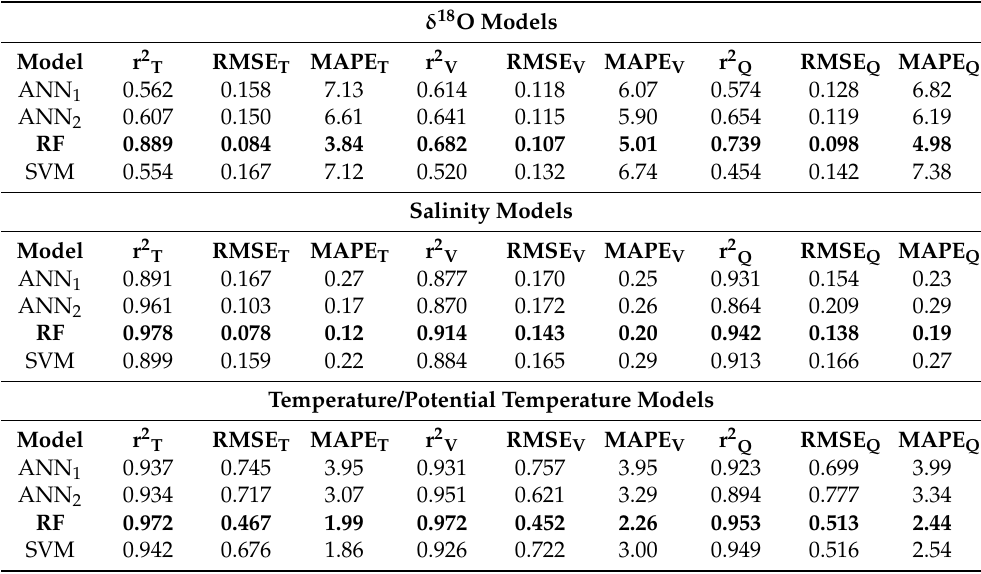
Table 2. Models developed with Longitude, Latitude, Year, Month and Depth. The model corre- sponds with the best implemented model: artificial neural networks type I (ANN 1 ), artificial neural networks type II (ANN 2 ), random forest (RF) and support vector machine (SVM). r 2 is the squared correlation coefficient, RMSE is the root mean square error (in ‰ for δ 18 O and salinity, and ◦ C for temperature/potential temperature) and MAPE is the mean absolute percentage error (%), for the real and the predicted data. Subscript T identifies the training phase, V the validation phase and Q the querying phase. (Bold shows the best model for each